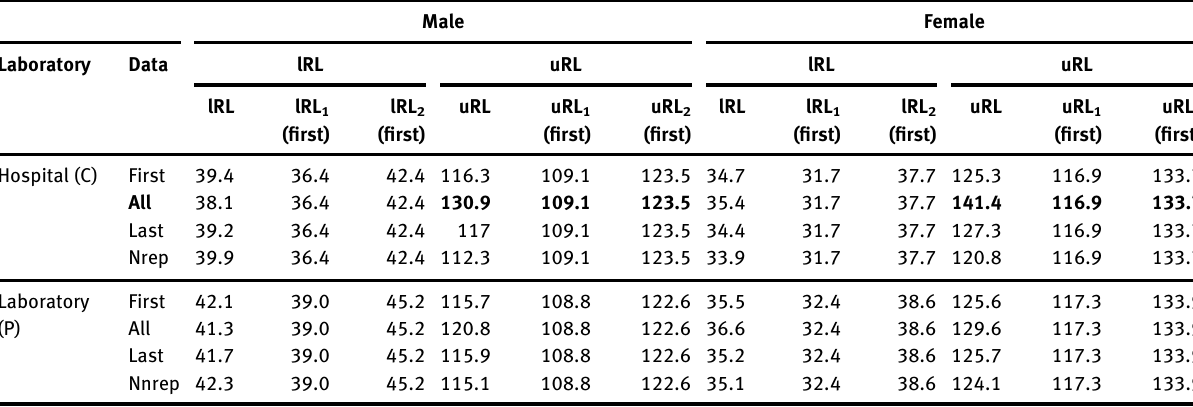
Table  : Comparisonofpermissibleuncertainty(pU)ofestimatedRLs(lRLanduRL)forAPvaluesobtainedfromahospital(C)andalaboratory (P) through “ fi rst ” data set with estimated RLs through “ all ” , “ last ” and “ non-repeated ” data sets